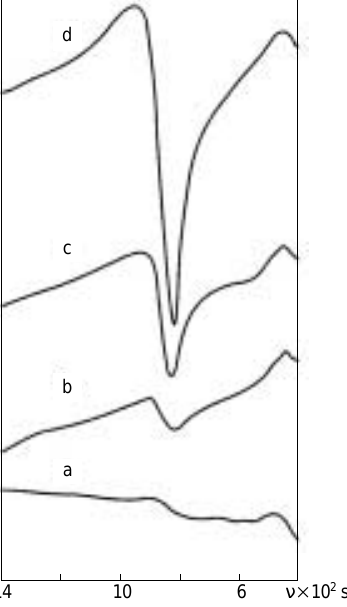
Fig. 16 IR spectra of an initial mixture of barium peroxide with WO 2 (a), after its mechanical activation for 10 s (b) and 2 min. (c), of the SHS product in this mixture